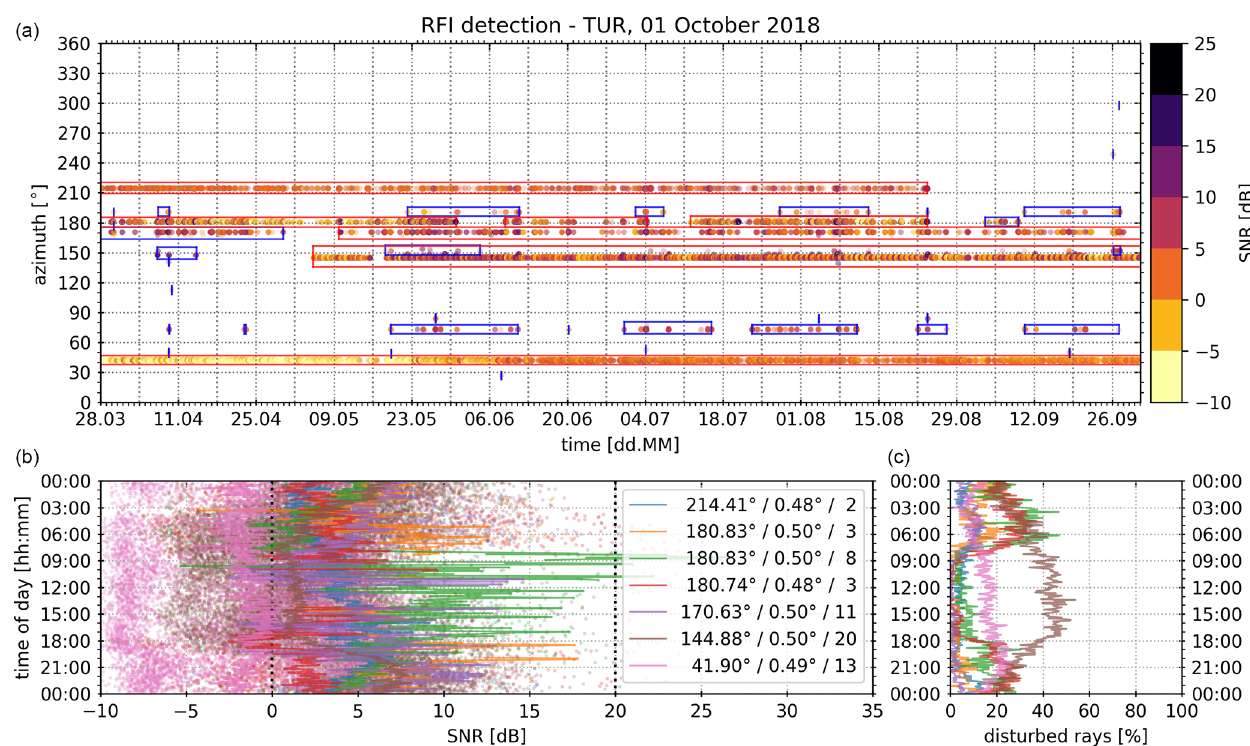
Figure A1. An operational RFI analysis from the radar site Türkheim (TUR) on 1 October 2018. Included are disturbed rays over 6 months. Panel (a) shows each disturbed ray as a dot in the scatter plot (colour of dots depicts the median SNR). All detected RFI sources with an RFI severity greater than or equal to zero are marked with a red box, while blue boxes mark RFI sources with an RFI severity below zero. In (b) additional properties of each red RFI box are displayed. The data in both bottom panels are accumulated into 5min bins according to the time of day ( y axis). Panel (b) shows SNR, and (c) shows the fraction of disturbed rays. Within the legend, the mean azimuth, mean elevation and RFI severity of each red RFI box are